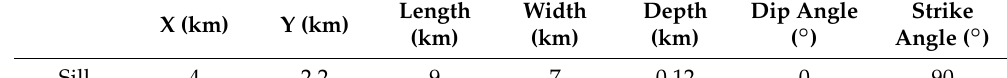
Table 2. Geometric parameters used in the sill inversion model.